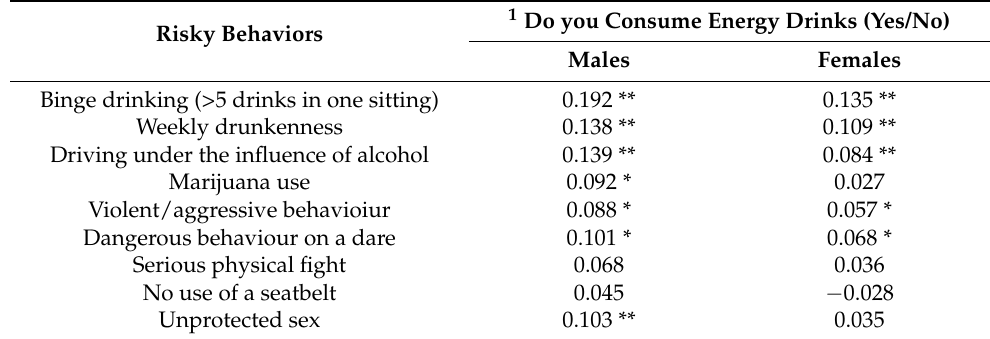
Table 1. Spearman’s Rho correlation coefficients for risky behaviors and ED consumption. 1 Do you Consume Energy Drinks (Yes/No) Risky Behaviors Males Binge drinking (>5 drinks in one sitting)